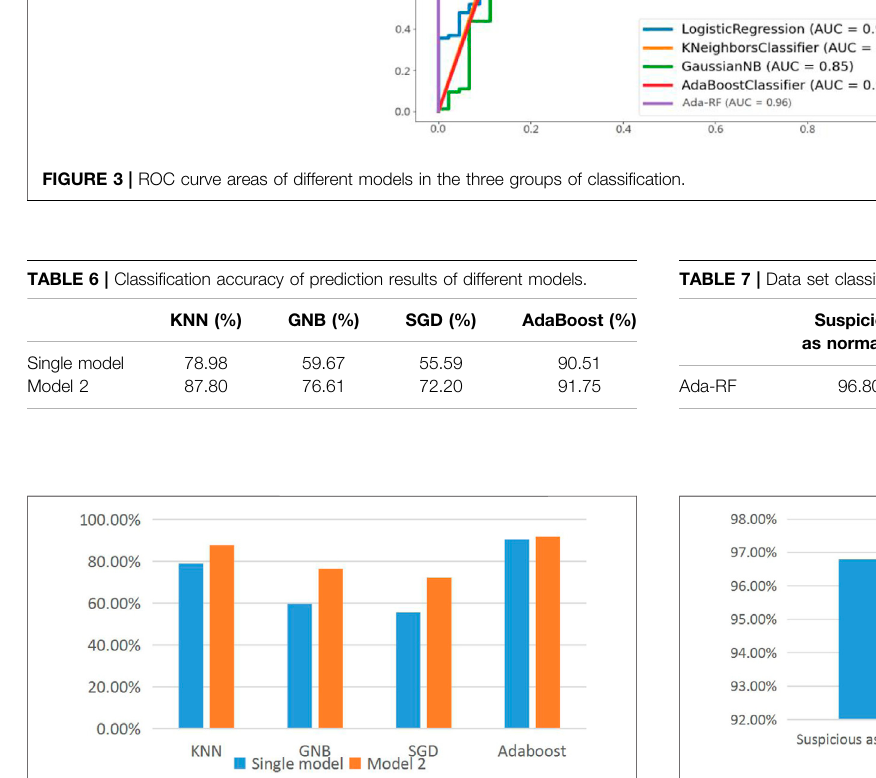
FIGURE 5 | Histogram of the classi fi cation accuracy of the data